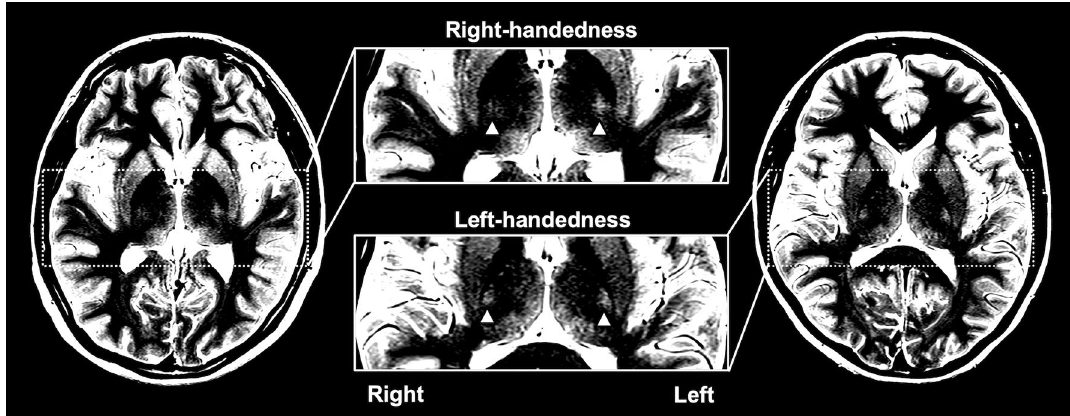
Figure 3. Bilateral corticofugal fibers signal intensities in right- and left-handed individuals (typical cases). The brain image on the left shows the slice of a right-handed participant, and the brain image on the right shows the slice of a brain image of a left-handed participant (window level 375, window width 100). White triangles indicate the CFT structures. For right-handed participants, the signal intensity of the left CFT structure was higher than that of the right CFT structure. For left-handed participants, we found the signal intensities of the left and right CFT structures to be almost